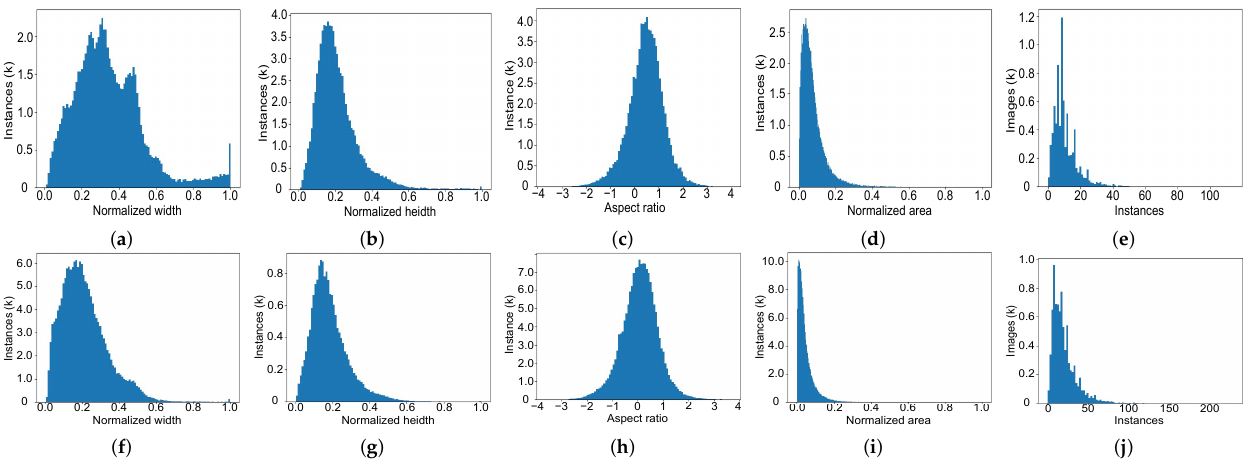
Figure 3. The numbers of images with respective to four labels in the LSCD, which includes Carton- inner-all, Carton-inner-occlusion, Carton-outer-all, and Carton-outer-occlusion.